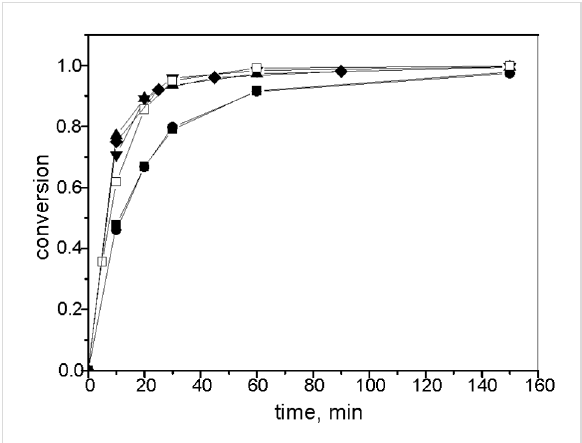
Figure 3: Conversion curves for the RCM of DEDAM with 3 in CH 2 Cl 2 (open squares), 3 /SBA-15 in CH 2 Cl 2 (inverted filled triangle), 3 /SBA-15 in benzene (filled diamond), 3 /SBA-15 in cyclohexane (filled triangle), and for the RCM of 1,7-octadiene with 3 /SBA-15 (filled squares) and 3 / MCM-41 (filled circles) in cyclohexane ( T = 30 °C, molar ratio sub- strate/Ru = 600, c 0 substrate = 0.2 mol/L).